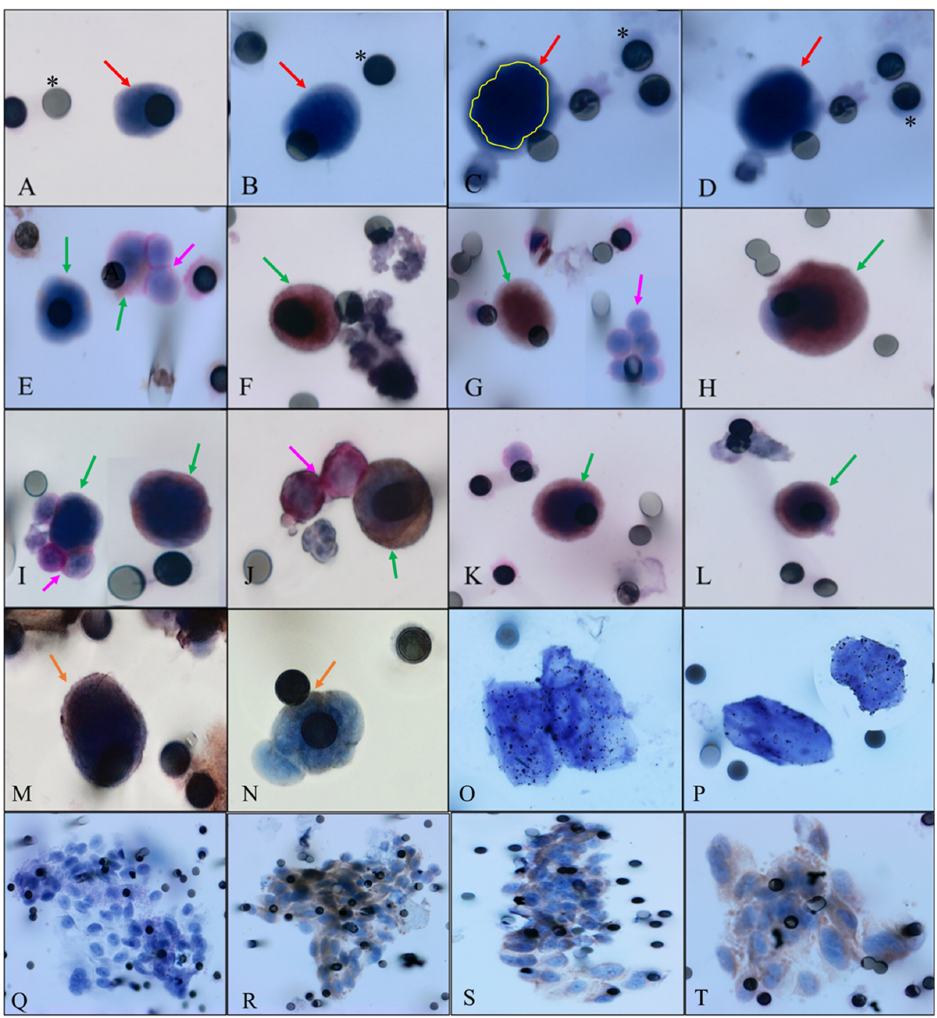
Figure 1. Representative images. Green arrows indicate hybrid cells, pink arrows represent leukocytes, red arrows represent CTCs, orange arrows indicate hybrids cells stained with CD45, yellow circle indicate cell nucleus and asterisks represent membrane pore. ( A , B ) CTCs without any staining, visualized with hematoxilin. ( C , D )The same CTC without any staining, in ( C ), nuclei defined by yellow line. ( E ) Hybrid cells. One positive for MC1-R (brown membrane) and one in a microemboli, stained with CD45 with two leukocytes (stained with CD45, visualized by permanent red). ( F ) Hybrid cell positive for MC1-R (brown membrane). ( G ) Hybrid cell positive for EpCAM (brown membrane) and a cluster of leukocytes (stained with CD45, visualized by permanent red). ( H ) Hybrid cell double positive for EpCAM (brown membrane) and MC1-R (visualized by permanent red). ( I ) Two hybrid cells. One visualized alone double stained with EpCAM and CD45 (brown and red) and the other surrounded by three leukocytes stained with CD45 (visualized by permanent red). ( J ) Hybrid cell stained with MC1-R, visualized by DAB and two leukocytes (stained with CD45, visualized by permanent red). ( K , L ) Hybrid cells positive for MC1-R/CD45 (brown and red membrane). ( M , N ) Hybrids cells stained with CD45 in just one side of the cytoplasmatic membrane, visualized by DAB. ( O , P ) CTCs positive for CEN8, indicating the presence of polyploidy. ( Q ) Mi- croemboli visualized with hematoxylin. ( R – T ) Microemboli from patient positive for MC1-R (brown membrane). Images were taken at × 400 and × 600 magnification using a light microscope (Research System Microscope BX61—Olympus, Tokyo, Ja-pan) coupled to a digital camera (SC100—Olympus, Tokyo,